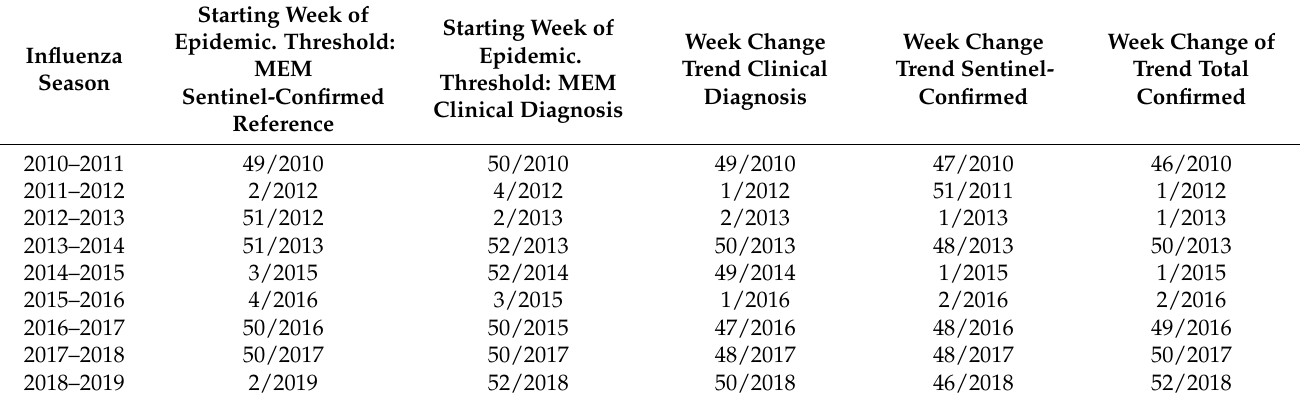
Table 2. Result of the Joinpoint analysis of the rate curves for clinical diagnoses, sentinel-confirmed and total confirmed for complete